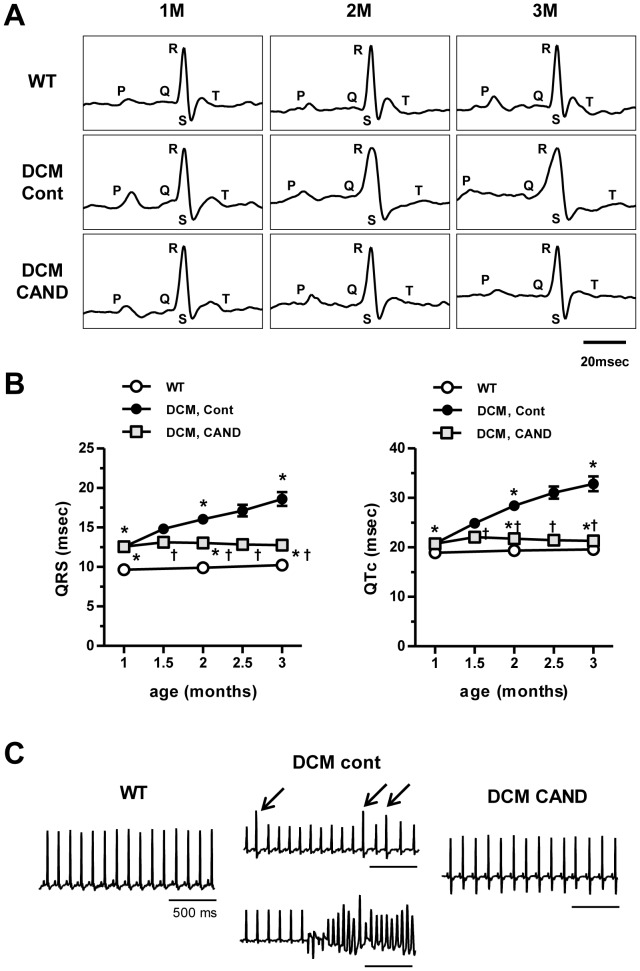
Effects of candesartan on ECG data.
A. Typical traces of ECG in a time course. B. Comparison of QRS and QTc intervals in WT (n = 11), control (n = 11) and candesartan-treated DCM mice (n = 12). *P<0.05 vs WT, †P<0.05 vs control DCM. C. Typical ECG records obtained with a telemetric recording system. Left: normal ECG trace from WT mouse. Center: representative traces of PVCs (upper panel, arrows) and VT (lower panel) in control DCM mice. Right: representative normal ECG trace from candesartan-treated DCM mouse.